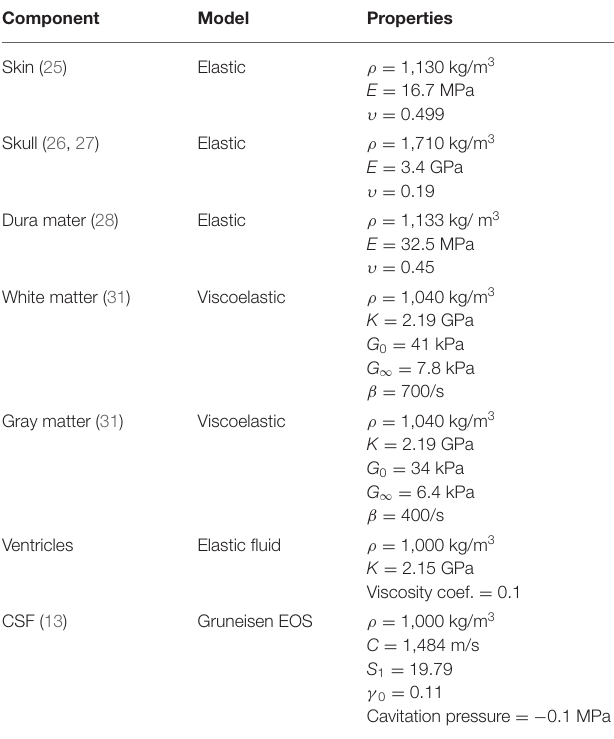
TABLE 1 | Material properties used in the head model.